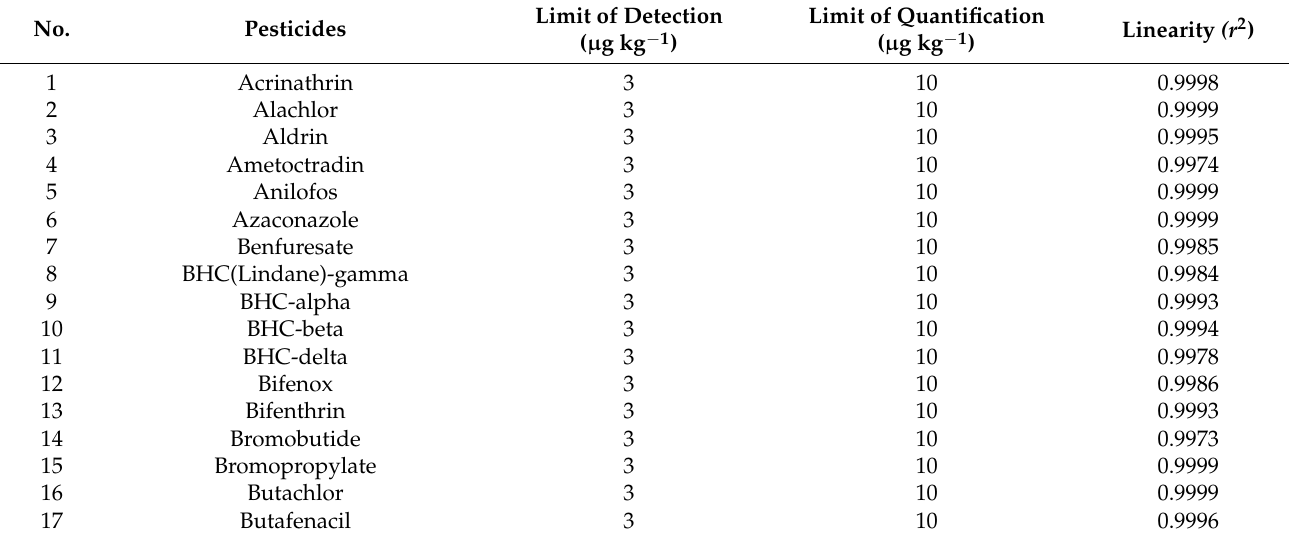
Table 3. LOD, LOQ, and linearity of the first 40 pesticides using GC–MS/MS. LOD, LOQ, and linearity of the other 83 pesticides are listed in Table